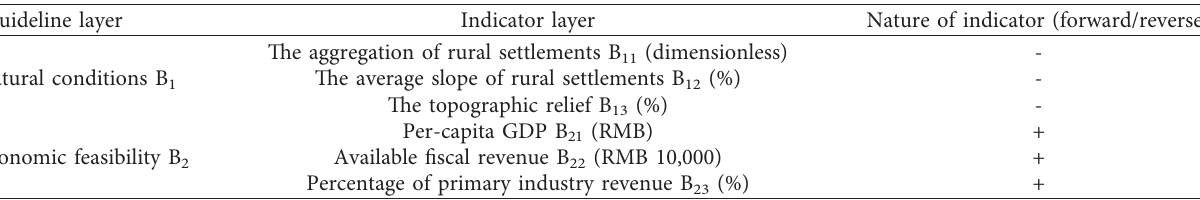
Table 1: Rural residential land consolidation real potential correction factor evaluation index system considering natural conditions and economic